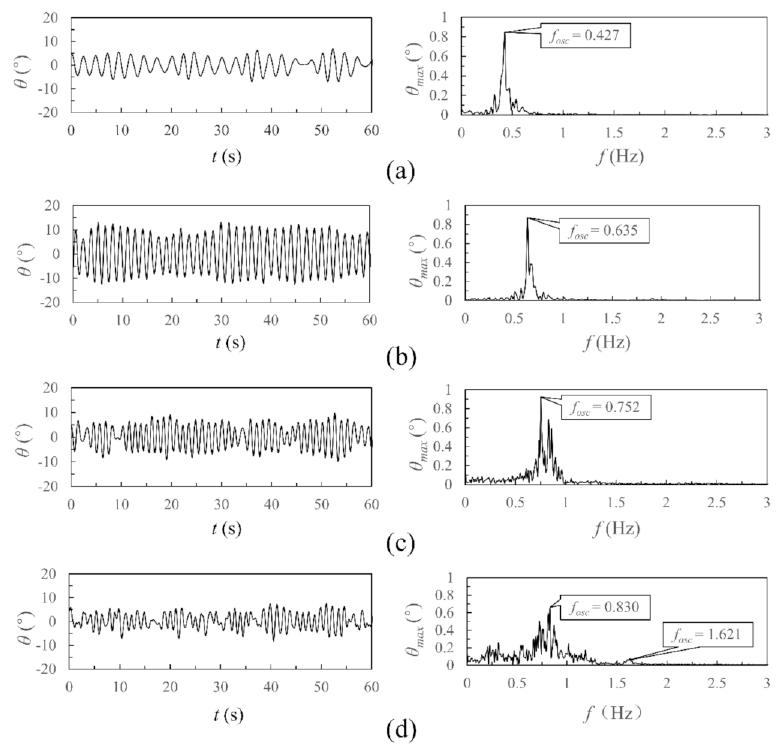
Figure 20. Rotational oscillation time history and spectral characteristics at L / D = 8.0: ( a ) U = 0.265 m/s ( U r = 3.29); ( b ) U = 0.483 m/s ( U r = 5.993); ( c ) U = 0.628 m/s ( U r =7.794); ( d ) U = 0.810 m/s ( U r =